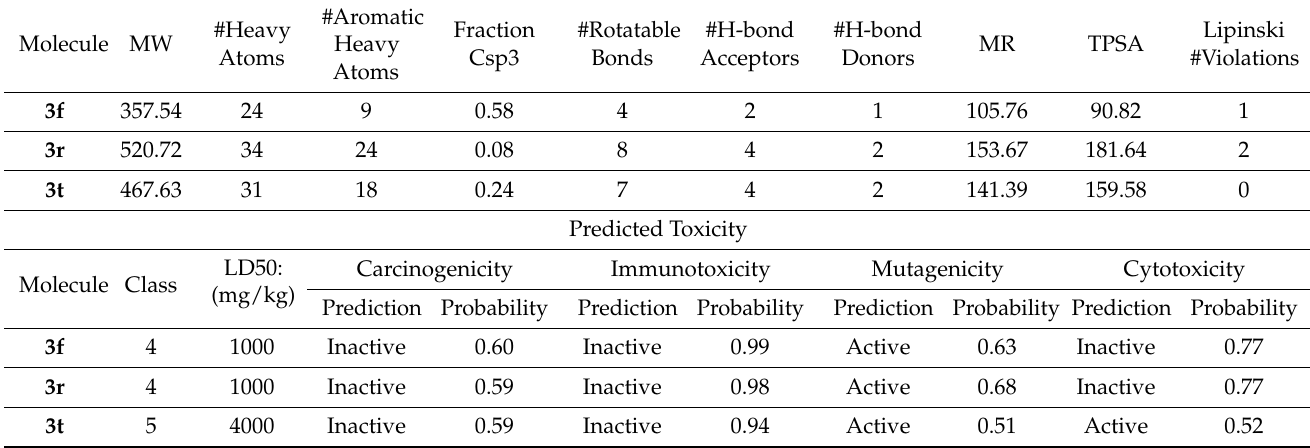
Table 2. ADME, toxicological and permeability prediction of 3f , 3r and 3t